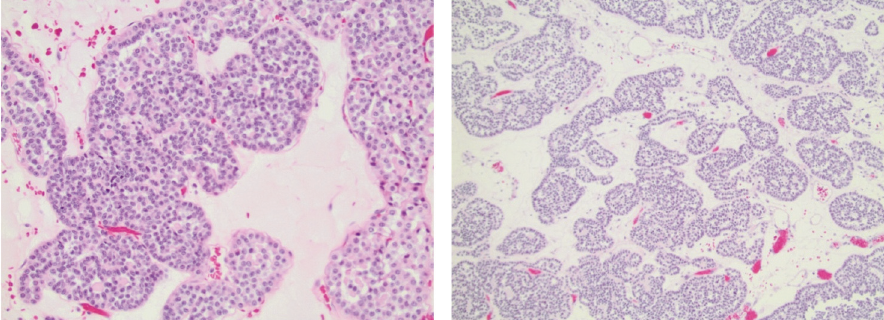
Figure 2: Histological findings of oncocytoma with large eosinophilic cells arranged in distinct